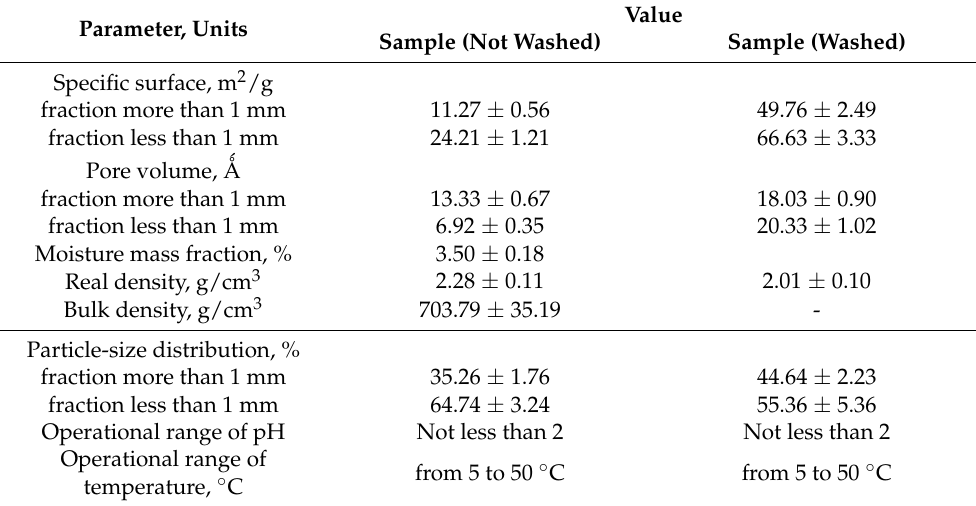
Table 10. Physical and chemical parameters of the investigated organic material (preliminary washed and not